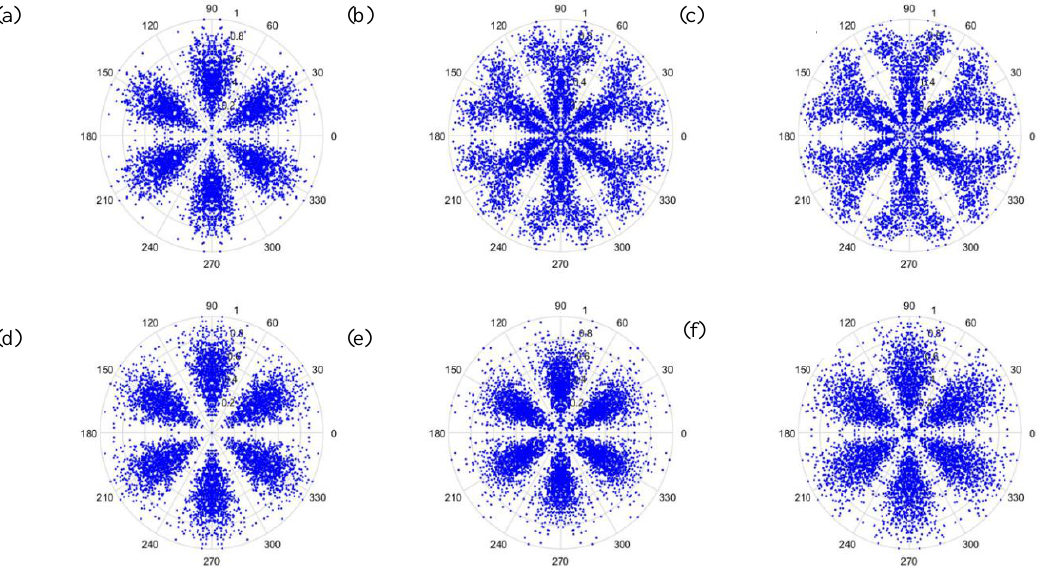
Figure 15. Results by improved formula when t = 1 and sampling is at 3000 Hz / 2000 rpm. ( a ) Normal, ( b ) motor platform with one eccentric screw, ( c ) motor platform with two eccentric screws, ( d ) sanded ball bearings, ( e ) insu ffi cient lubrication, and ( f ) worn ball